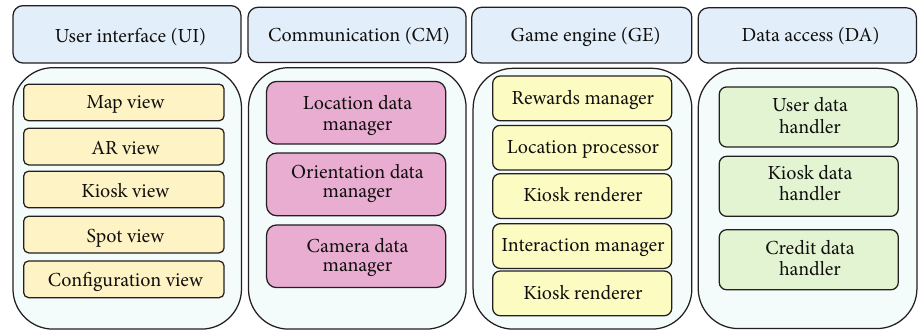
Figure 1: The architecture of KioskAR including client and server side components.